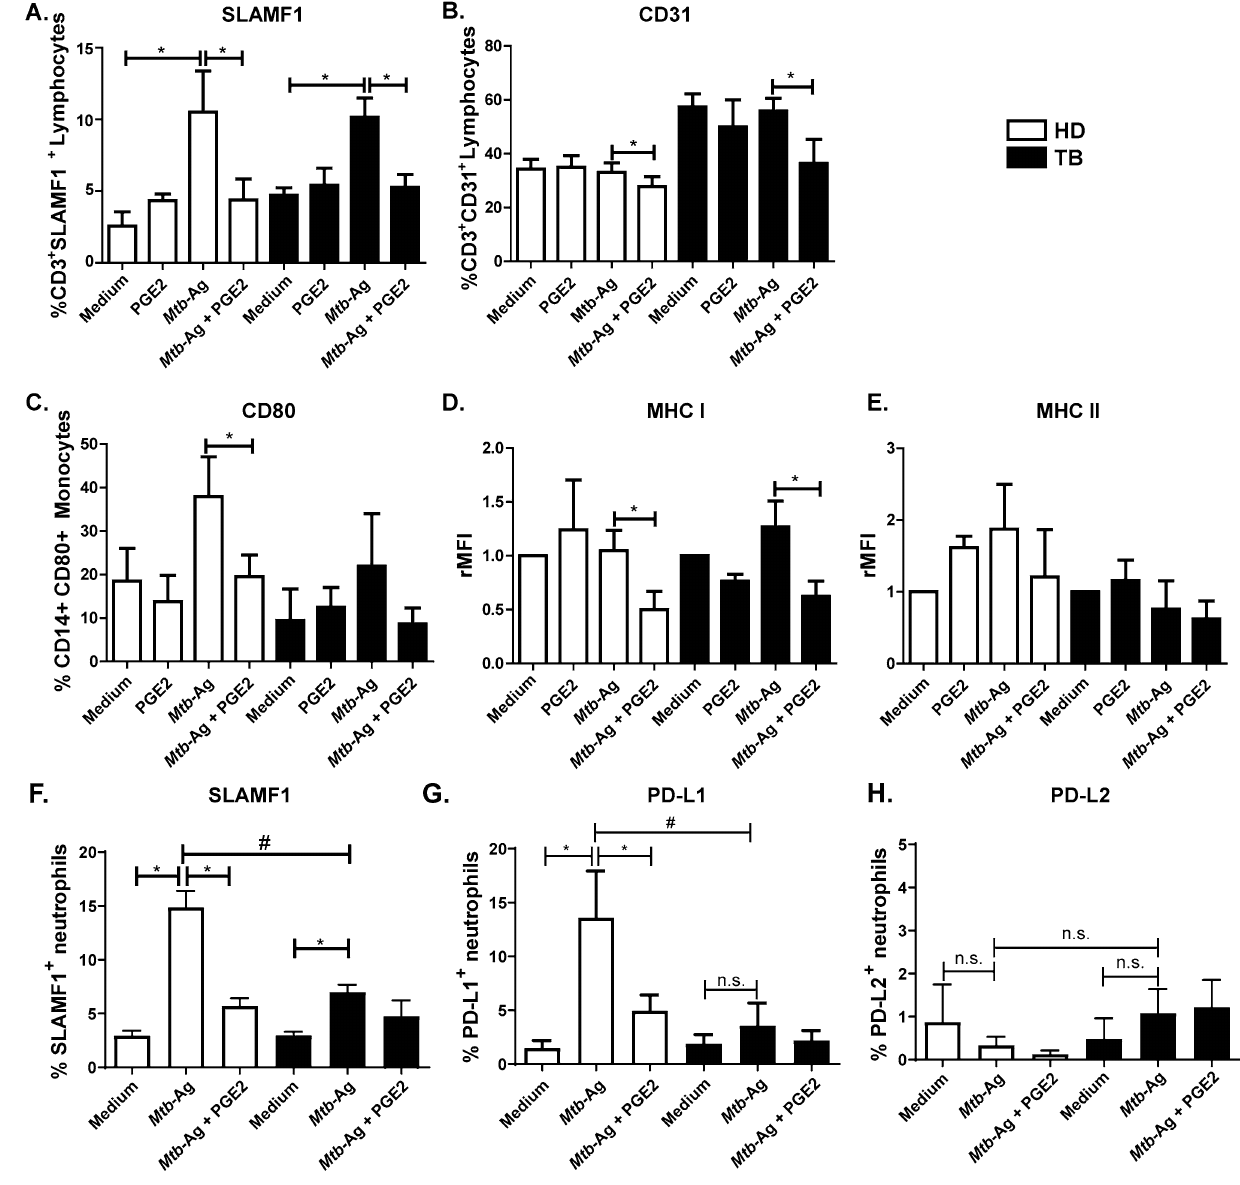
Figure 2. PGE2 regulates the expression of surface receptors on PBMC and neutrophils from HD and TB patients. ( A – E ) PBMC from HD (n = 7) and TB patients (n = 11) were stimulated with Mtb -Ag (10 µg/ml) in the presence or absence of PGE2 (2 µM) for 5 days. Afterwards, the surface expression of ( A ) SLAMF1 and ( B ) CD31 on CD3 + T cells and ( C ) CD80, ( D ) MHC-I and ( E ) MHC-II on CD14 + mononuclear phagocytes were determined by flow cytometry. Each bar represents the mean percentage of ( A – C ) CD3 + or ( D,E ) CD14 + Receptor + cells ± SEM or relative Mean Fluorescence Intensity (rMFI) ± SEM. ( F – H ) Human purified neutrophils from HD (n = 7) and TB patients (n = 6) were stimulated with Mtb -Ag (10 µg/ml) in the presence or absence of PGE2 (2 µM) for 2 h. Then, ( F ) SLAMF1, ( G ) PD-L1 and ( H ) PD-L2 expressions were evaluated by flow cytometry. Bars represent the mean values of the percentage of Receptor + neutrophils ± SEM. Statistical differences were calculated using one-way ANOVA and post hoc Dunnett’s multiple comparison test. * p < 0.05. # p < 0.05; Mann–Whitney nonparametric test for unpaired